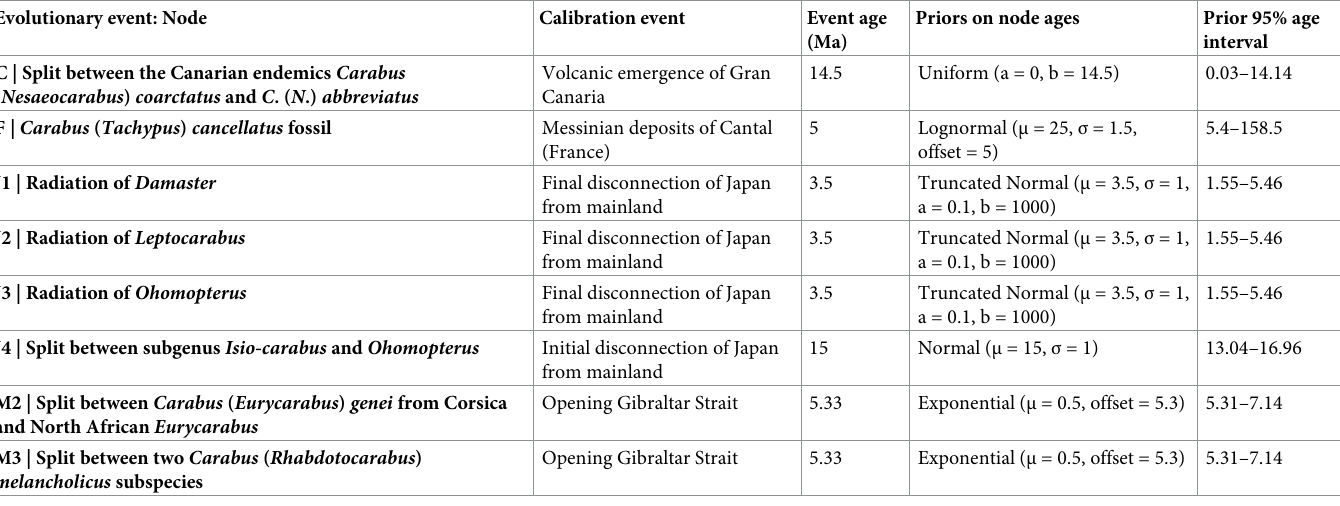
Table 1. Calibration scheme from Andu´jar et al. 2012 [16].